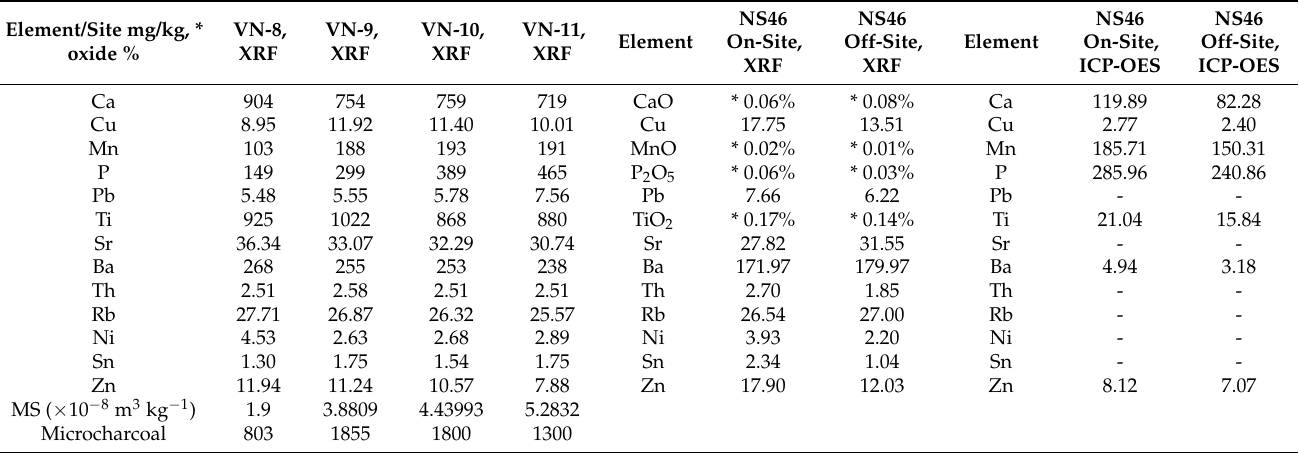
Table 5. Major anthropogenic geochemical indicators at Voorthuizen (samples VN 8-11) and Nistel- rode (samples NS46) archaeological sites, The Netherlands. Unmarked element values expressed in mg/kg, * marked element oxides values expressed in